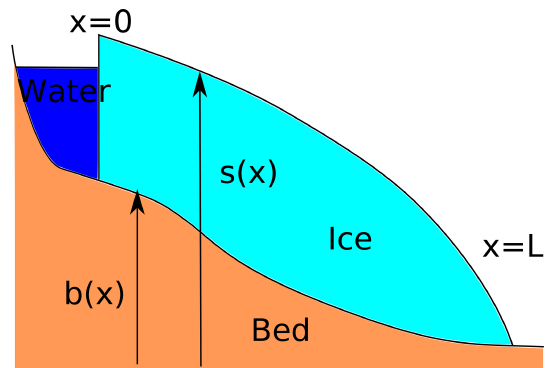
Figure 1. Geometry of the problem: the conduit runs along the ice– bed